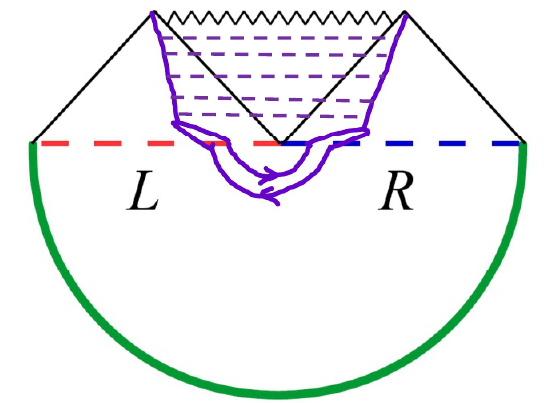
Figure 1 . The Hartle-Hawking wave function and the non-perturbative (cid:11) 0 corrections. In the Euclidean section there are strings with winding number (cid:6) 1, denoted in the text by W (cid:6) . They are combined in the Lorentzian section to form a folded string, F , that can be viewed as a fusion of W + and W (cid:0)